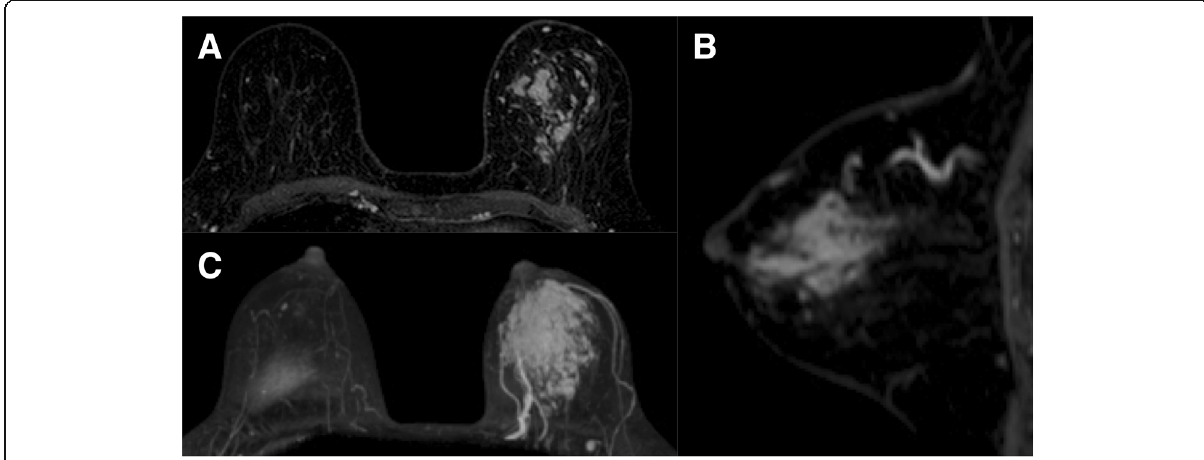
Fig. 3 Findings from an enhanced magnetic resonance imaging scan of the breast. a , b Fat suppression. c MIP. Numerous punctate areas of contrast with dynamic washout were detected throughout the left breast. No invasion of the pectoral muscle, chest wall, or skin was observed